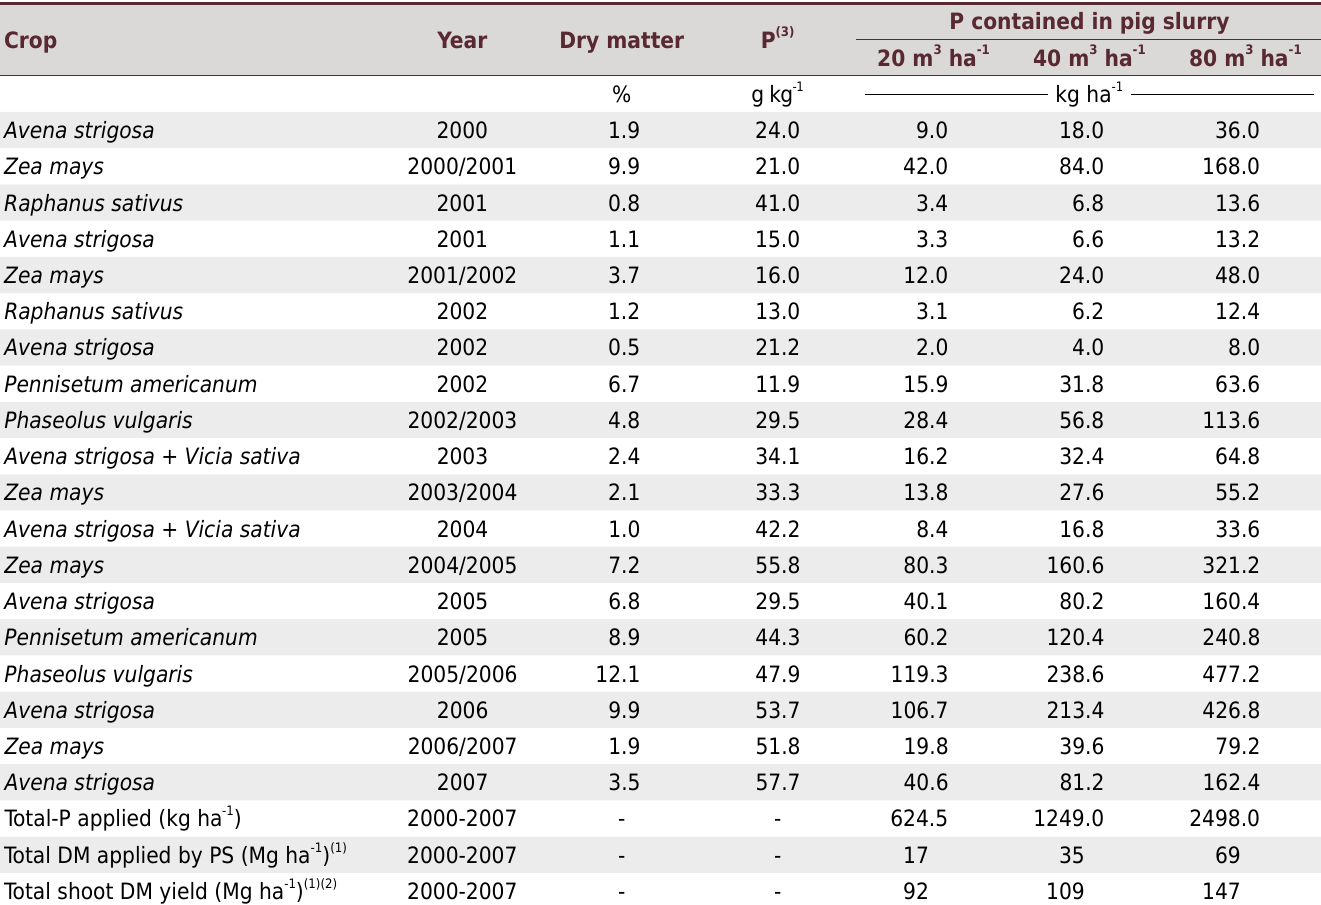
Table 1. Cropping history, chemical composition of PS, and amount of P applied by PS at each application during experiment, and the total amount of dry matter (DM) applied by PS, and total amount of shoot yield in eight experimental years in Santa Maria, Rio Grande do Sul, Southern Brazil